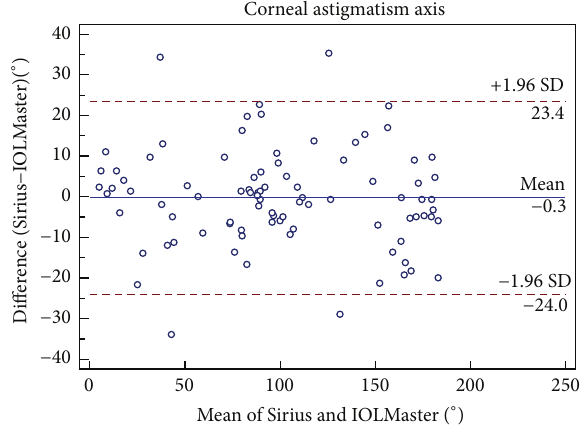
Figure 5: Bland-Altman plots of agreement of mean corneal astigmatism axis readings taken with the Sirius Scheimpflug/Placido photography-based topography system and IOLMaster partial coherence interferometry. The solid line indicates the mean differ- ence (bias). The upper and lower lines represent the 95% limits of agreement.